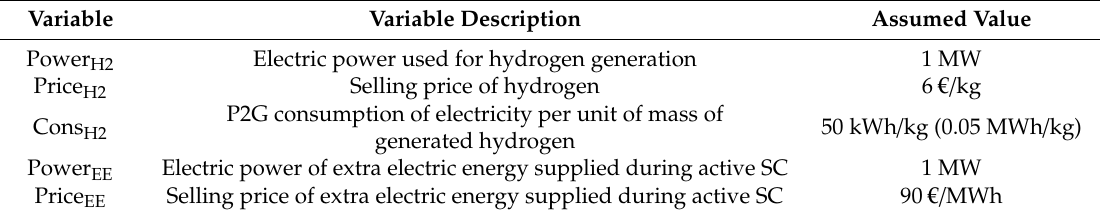
Table 5. Descriptions of the variables and their assumed